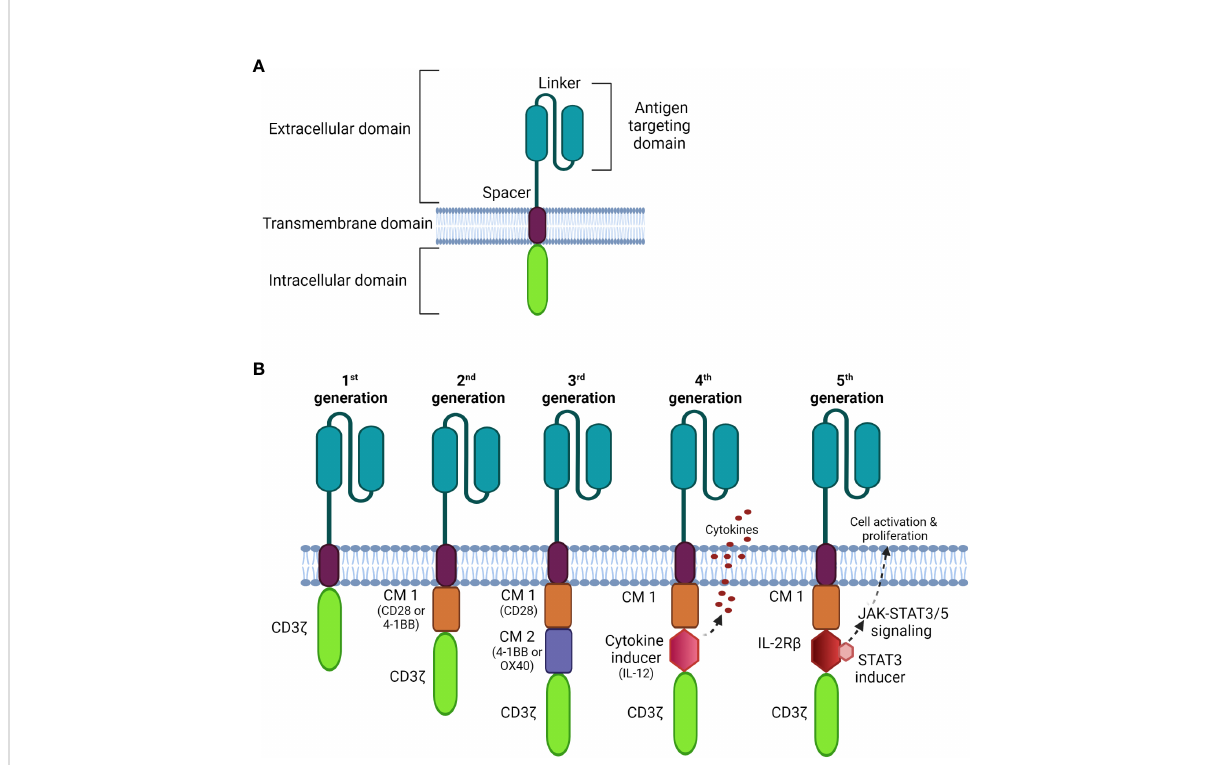
FIGURE 1 Schematic diagrams of CAR structures. (A) The basic structure of a CAR comprises the extracellular domain, a transmembrane domain, and the intracellular domain. (B) Comparison of four generations of CAR constructs. The fi rst generation CAR comprises only the T cell signaling domain CD3 z without the costimulation domain compared to the second generation, which includes one costimulatory molecule (CM); the third generation is generated with multi CMs, and the fourth generation is constructed with an additional cytokine transgenic gene to induce cytokines upon antigen engagement. The fi fth generation comprises additional intracellular domains of cytokine receptors (e.g. IL-2R b ) that allows JAK/STAT pathway activation to drive T cell activation and